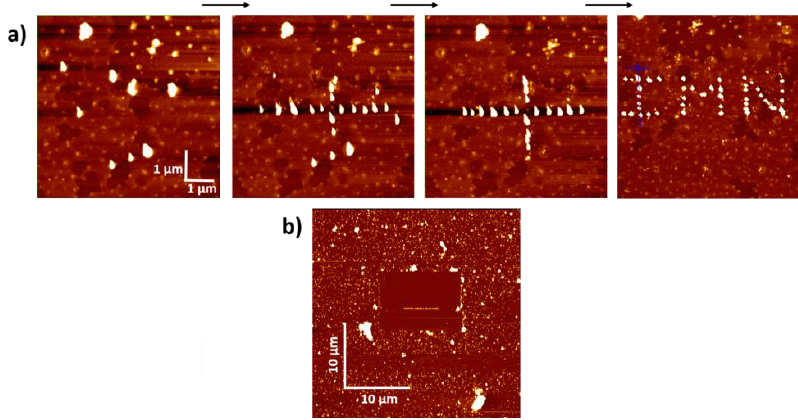
Figure 3. Examples of gold structures created by AFM manipulation; ( a ) different steps leading to a cross, then to the IMN logo; ( b ) long gold NP line of about 6 μm , the surrounding area being cleaned by the AFM-Tip in contact mode. (bar scales at top are 1 µm and down 10 µm).